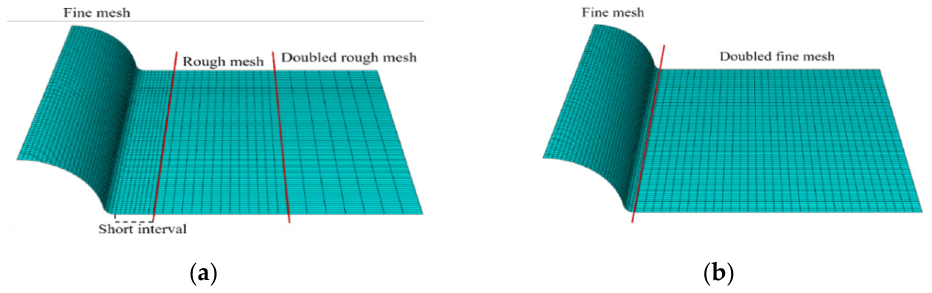
Figure 5. Schematic of mesh size distribution in ( a ) symmetric and asymmetric hydrodynamic pressure analysis and ( b ) thermal shrinkage analysis.